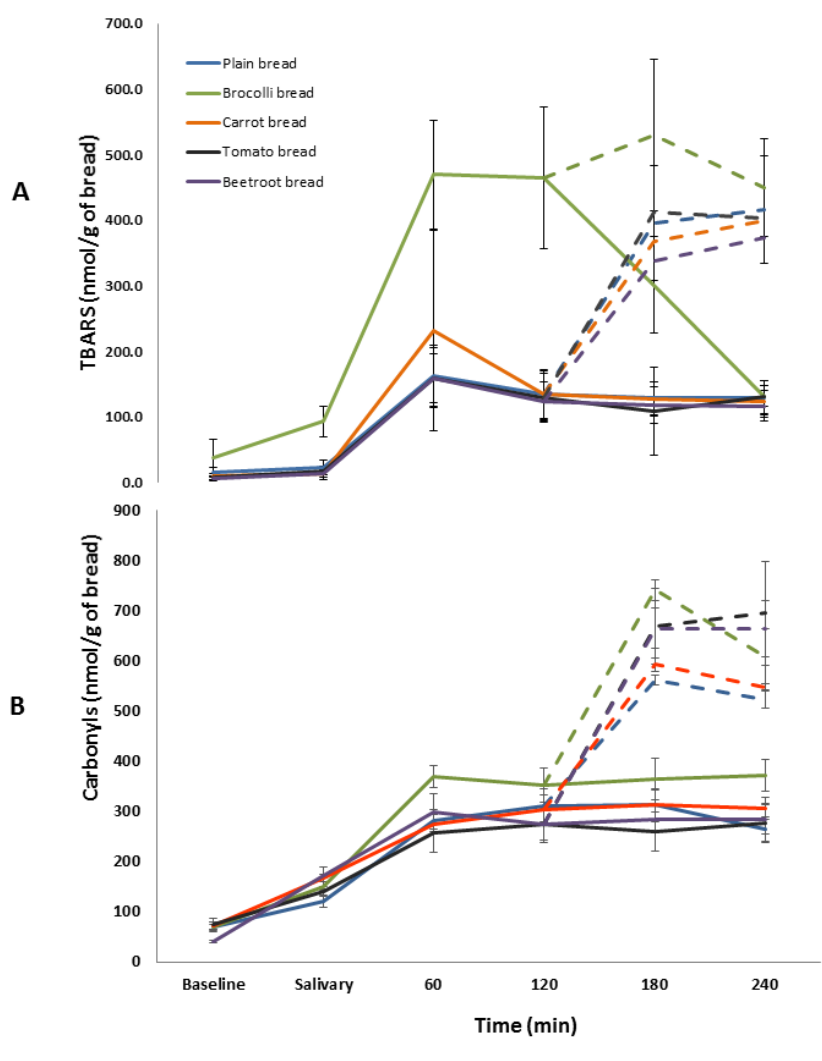
Figure 4. Temporal changes in TBARS ( A ) and protein carbonyls ( B ) production during gastro- intestinal digestion of the breads. Solid lines represent the salivary and gastric phases of digestion. The broken lines represent the intestinal phase of digestion. Values are means ± SE ( n = 6).